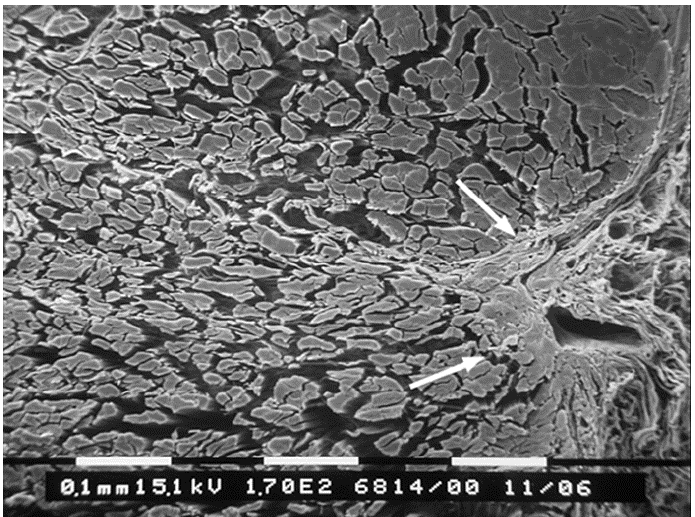
FIGURE 2. SEM image of transversally cut rat Achilles tendon. The polygonal collagen fascicles are clearly distinguishable. On the right paratenon is covering the surface of tendon and envelopes some blood vessels (arrows). From paratenon develops epitenon that runs deeply into the tendon. Bar = 100 μ